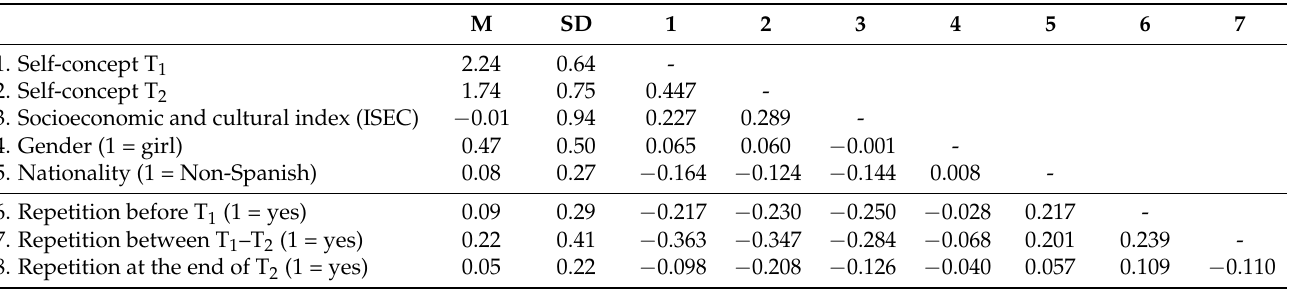
Table 1. Descriptive statistics and Pearson’s